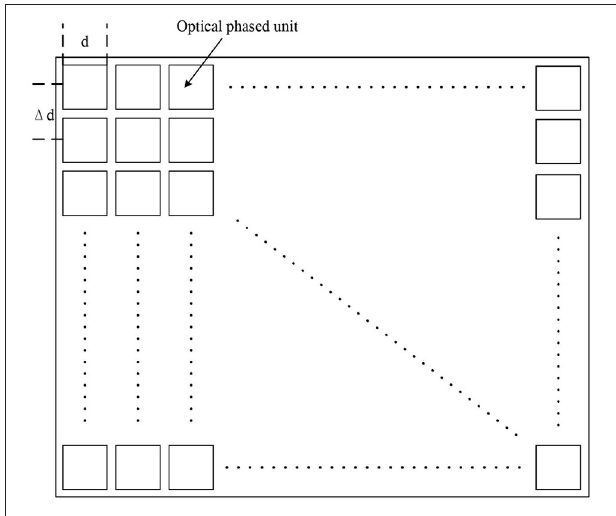
FIGURE 3 | Structure of the optical phased